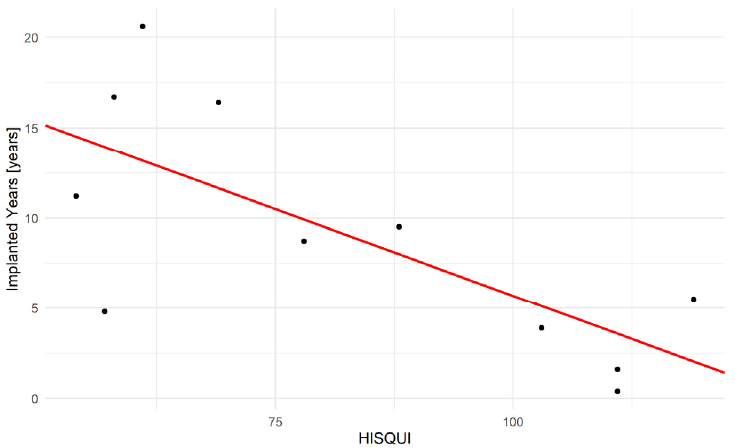
Figure 6. Correlation between years of implantation and the Hearing Implant Sound Quality Index (HISQUI). The individual values are shown as black dots, the correlation is show with the red line.